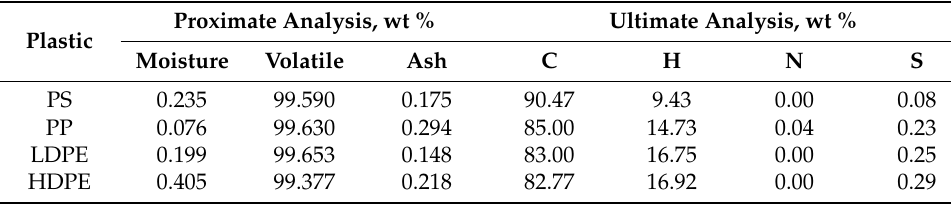
Table 1. Proximate and ultimate analysis of different waste plastics. Plastic